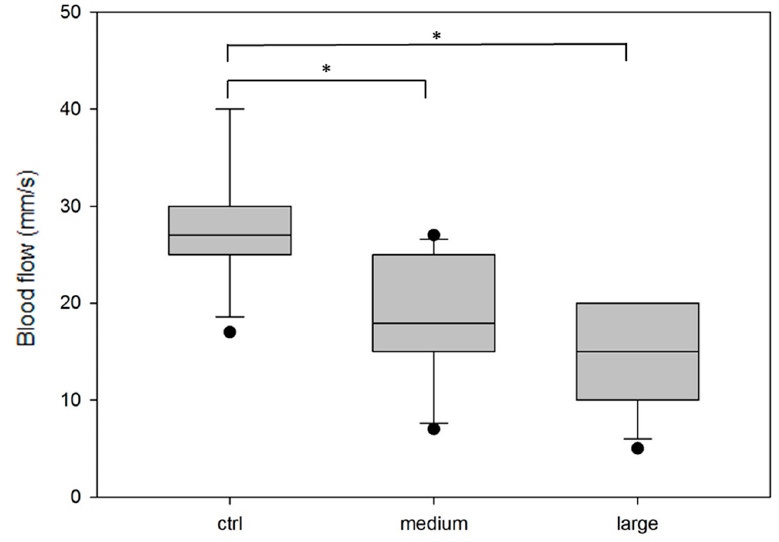
Figure 5. Range of the blood flow in the vasculature measured from Doppler USG images in the eyeballs without a tumor (ctrl) or in the tumor vasculature in medium-size and large tumors. The blood flow is measured in approximately 10 vessels from each experimental group. The box range is between 25th and 75th percentile. The line within the box indicates the median, the error bars indicate the 10th and 90th percentile, and the black dots indicate the outlying points. The statistical significance of the differences between the mean values is tested using one-way analysis of variance (Holm–Sidak test). Asterisks stand for p < 0.05.